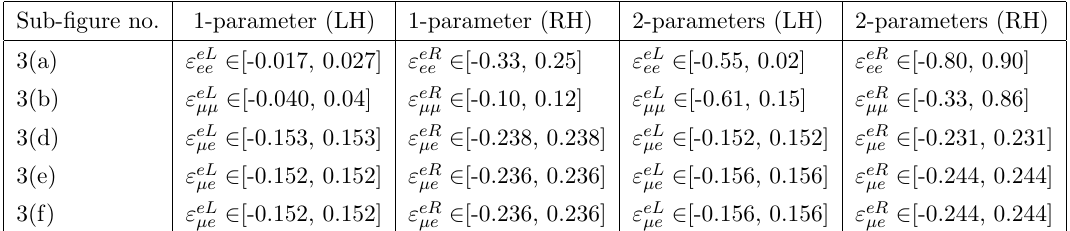
Table 3 . Parameter bounds from the detector-only study, with both 1-parameter and 2-parameter bounds given here at the 90% C.L.. As noted in the text, the 2-parameter bounds for cases (a), (b) and (c) lie partly outside the range where they can be considered perturbations on the SMM, they are given here for completeness. In all entries, the index (cid:22) can be replaced by (cid:28) and the e and (cid:22) subscripts